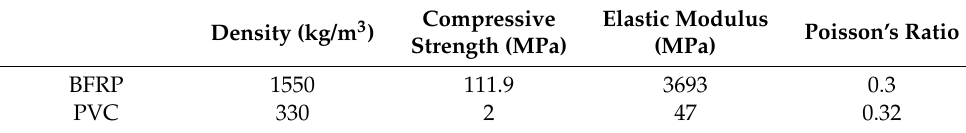
Table 1. Material properties for the FEA (Data from